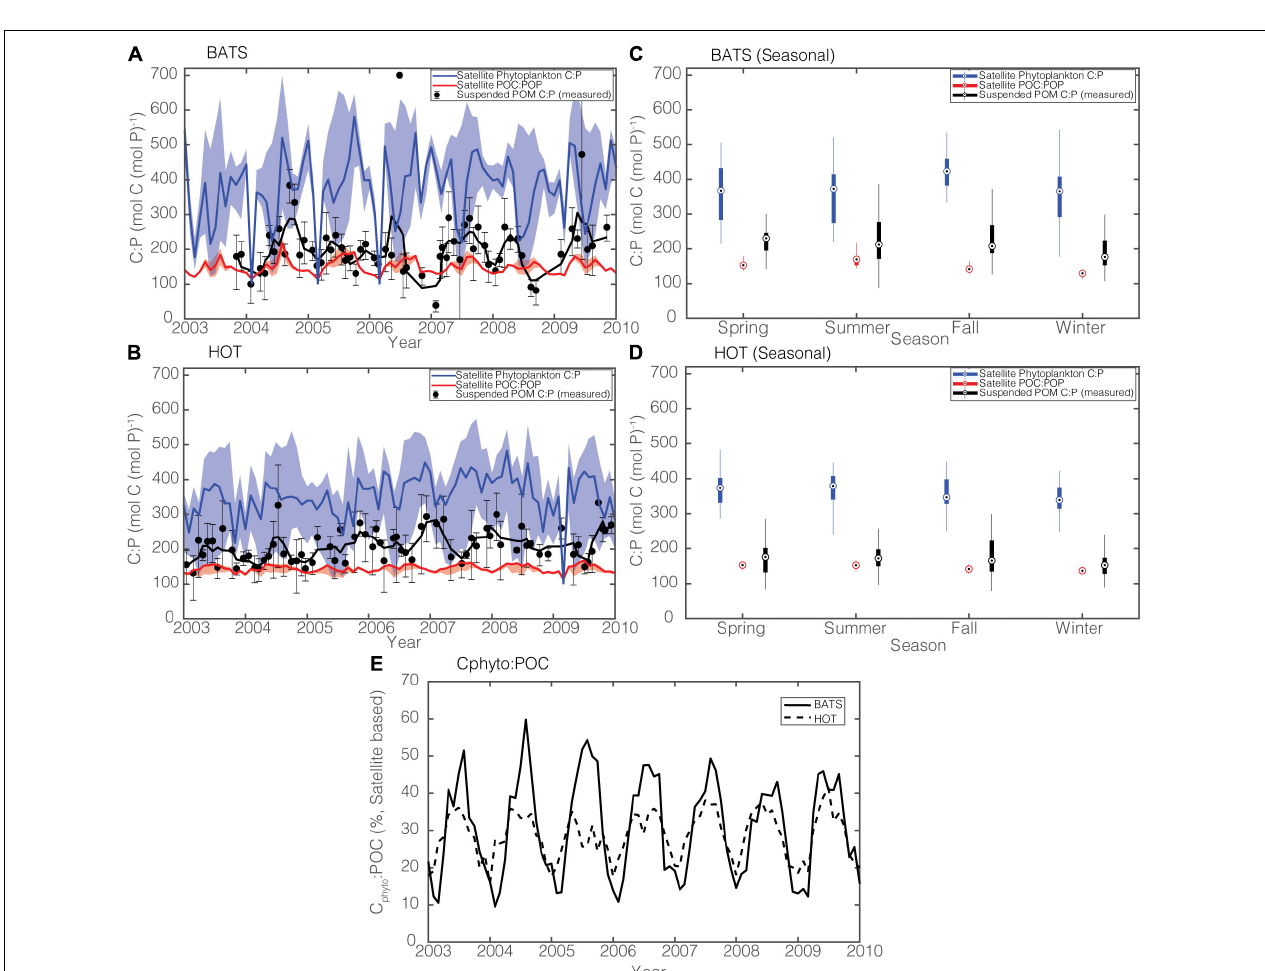
FIGURE 8 | (A,B) Comparison of observed and modeled monthly C:P stoichiometry during 2003–2010 in the surface 100 m for BATS and HOT. Solid black lines are 3-month running means, and sample error bars are products of the geometric standard deviation and the geometric mean. Solid blue and red lines are median estimates for satellite-informed r C : P and POC:POP, respectively. The shadings show the range. (C,D) Box-whisker plot comparing the annual ratios of satellite-informed phytoplankton C:P (blue), satellite-informed POC:POP (red), and in situ POC:POP (black). Each season represents a 3-month average (Spring = April to June, Summer = July to September, Fall = October to December, Winter: January to March). (E) Satellite-derived C phyto :POC at BATS (solid line) and at HOT (dotted